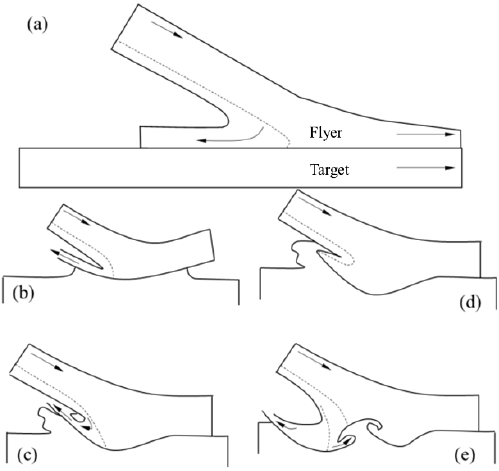
Figure 9. ( a – e ) the process of Bahrani caved mechanism (reproduce from [34], with permission of Royal Society 1967).